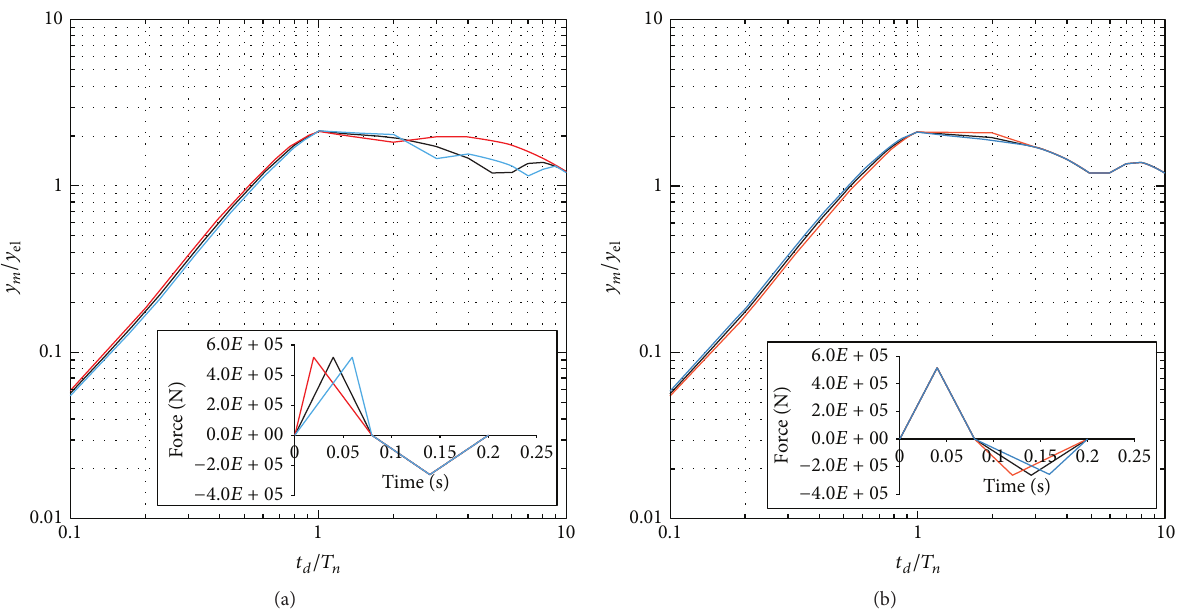
Figure 13: The analysis for the effect of loading rate (a) according to loading velocity of positive phase and (b) according to loading velocity of negative